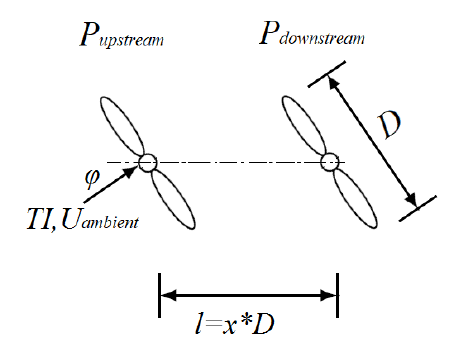
Figure 1. Illustration of the wind farm layout consisting of two turbines with diameter D and interspace l equal to x times the